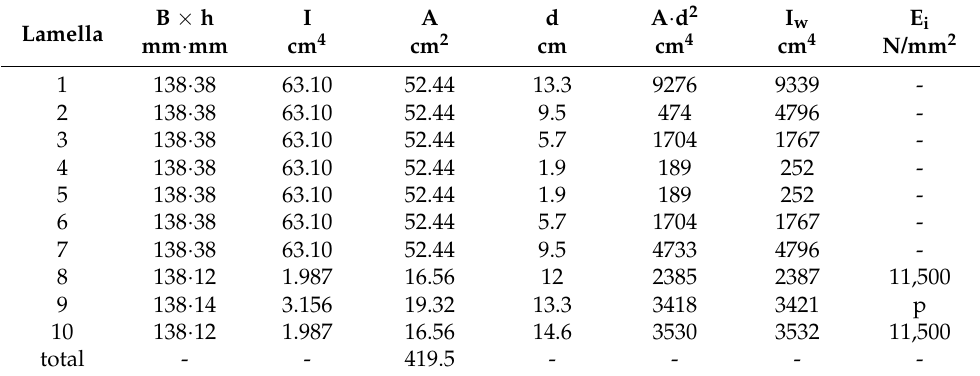
Table 3. Components of the principal moment of inertia in relation to the y-axis.